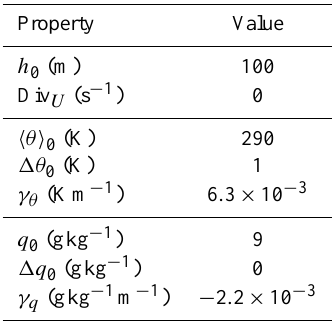
Fig. 18. Comparison between the observations and MXL model results for the (a) NO 2 and (b) O 3 mixing ratios during 6 August 2010. The numerical experiments are the standard case, the case for the lower shallow boundary layer until 9:30 LT and the case where a residual layer and the lower shallow boundary layer are connected and become one mixed layer from 9:30 LT onward. The latter two cases correspond to situation (1) and situation (3) in Fig. 12, respectively.